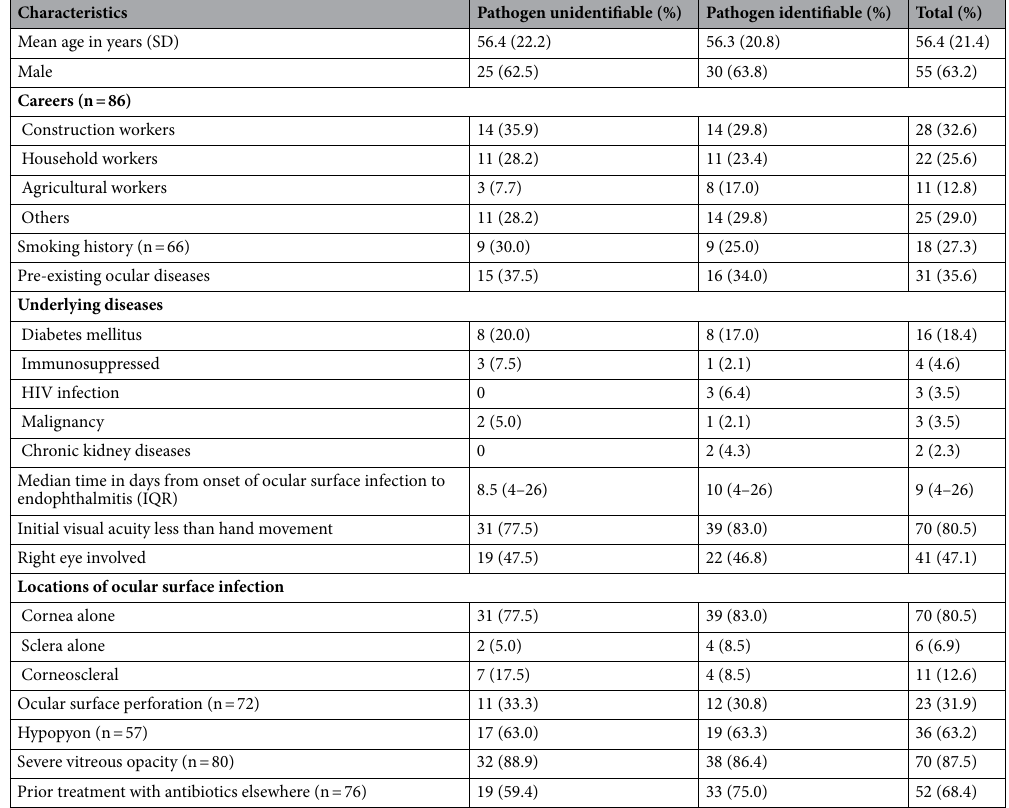
Table 1. Baseline characteristics of endophthalmitis associated with ocular surface infection in Siriraj hospital, Bangkok, Thailand from 2001 to 2011 (n = 87 patients, otherwise noted). SD standard deviation, HIV human immunodeficiency virus, IQR interquartile range.